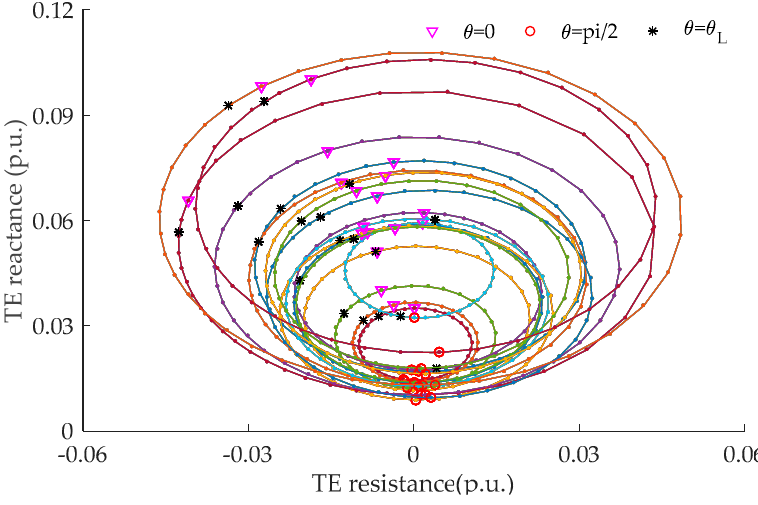
Figure 2. The calculated Thevenin equivalent (TE) impedances under different θ in complex plane.